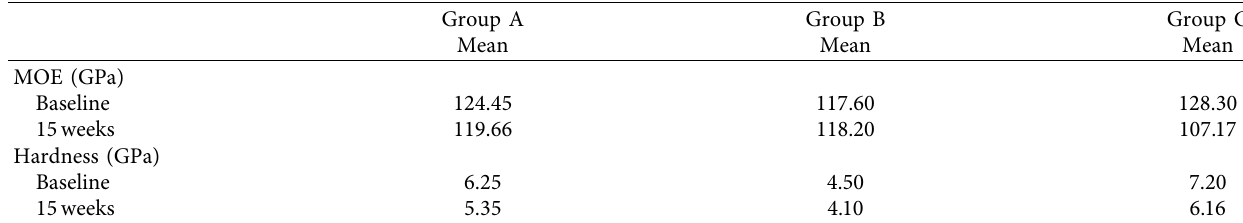
Table 4: Descriptive statistics with nanoindentation: modulus of elasticity and